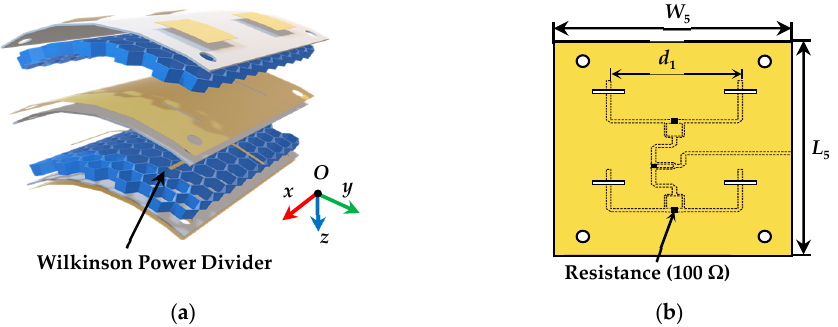
Figure 3. The coordinate geometry and dimensions of the proposed antenna array: ( a ) explosion view of the structure, ( b ) the feeding network with Wilkinson power divider and ground with four coupling apertures on the middle layer.